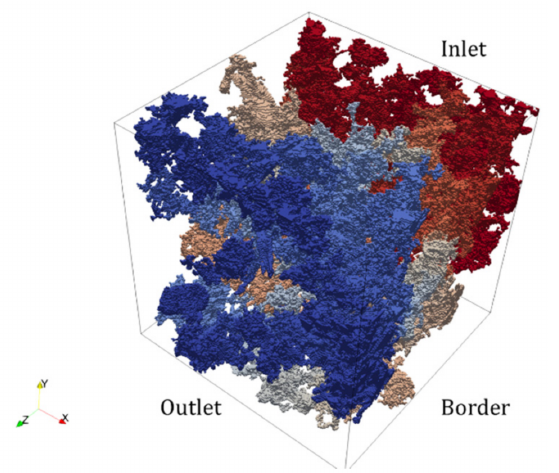
Figure 7. Computational domain of reconstructed 3D porous structure at N = 1000 and R = 0.25. Only pore part structure is presented. The color reflects the pressure